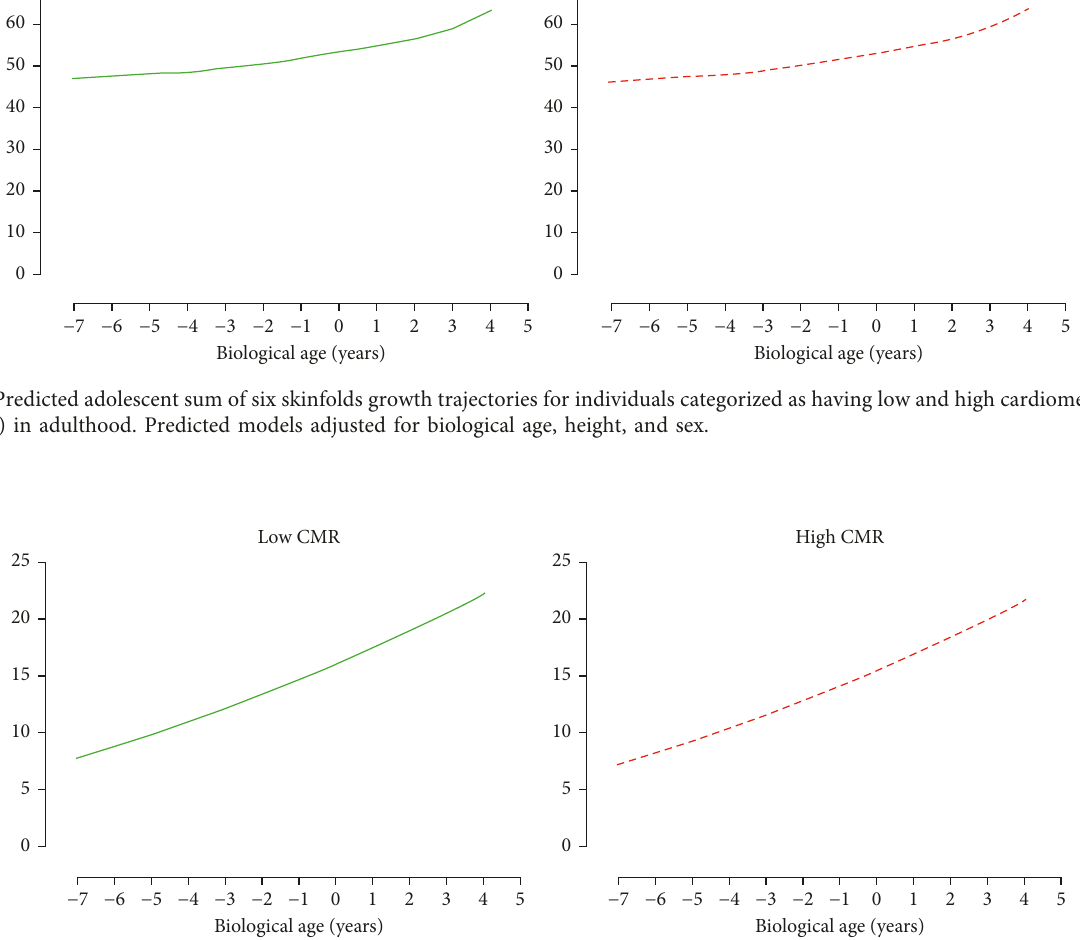
Figure 4: Predicted adolescent trunk skinfolds growth trajectories for individuals categorized as having low and high cardiometabolic risk (CMR) in adulthood. Predicted models adjusted for biological age, height, and sex.